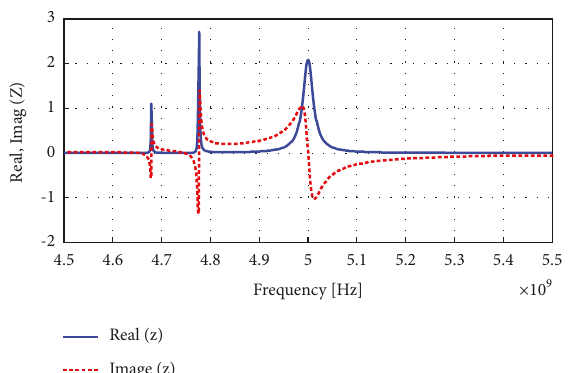
Figure 11: Frequencies of the metamaterial fractal antenna.